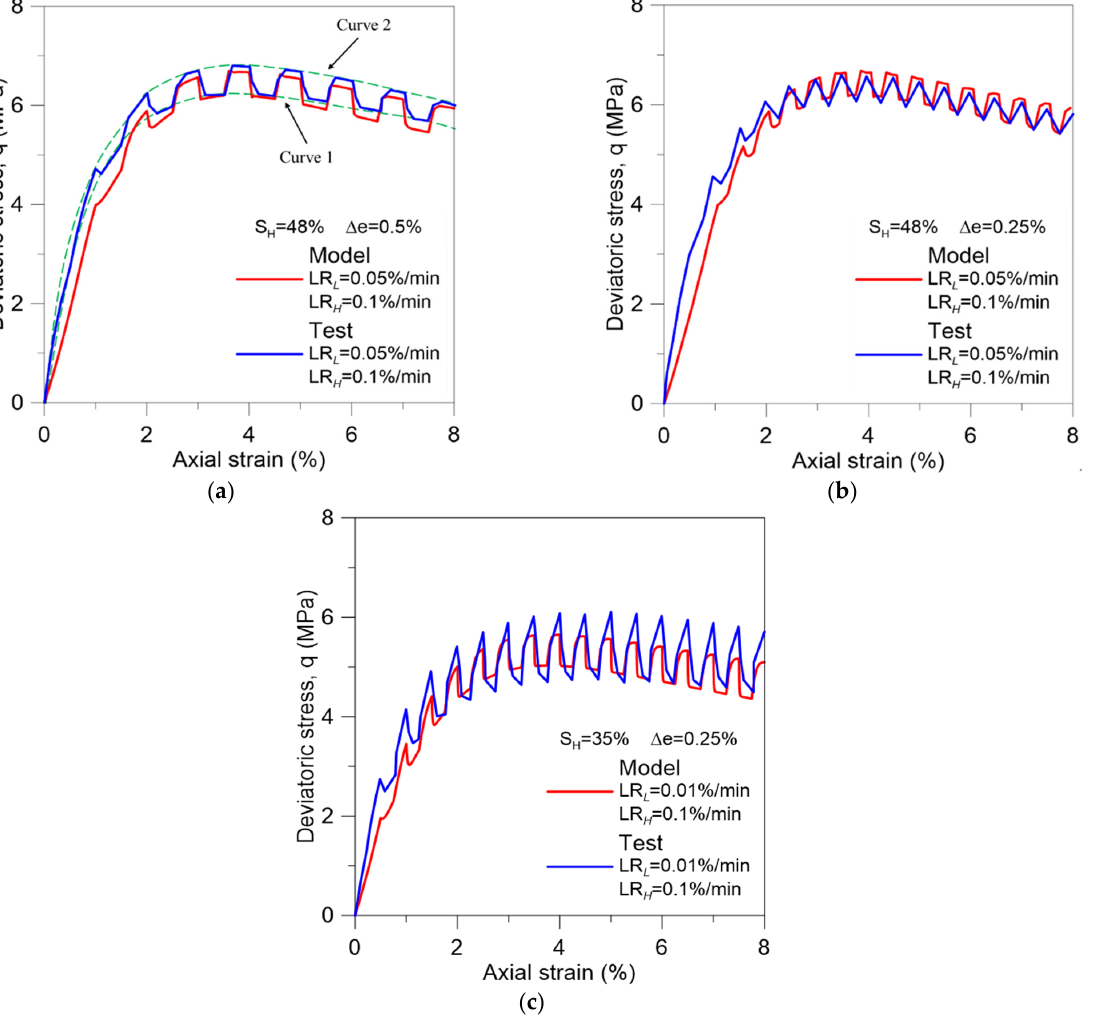
Figure 13. Case 2 considering effect of loading rate on MHBS behavior Miyazaki et al. [33]. ( a ) Test (I); ( b ) test (II); ( c ) test (III). (I); ( b ) test (II); ( c ) test